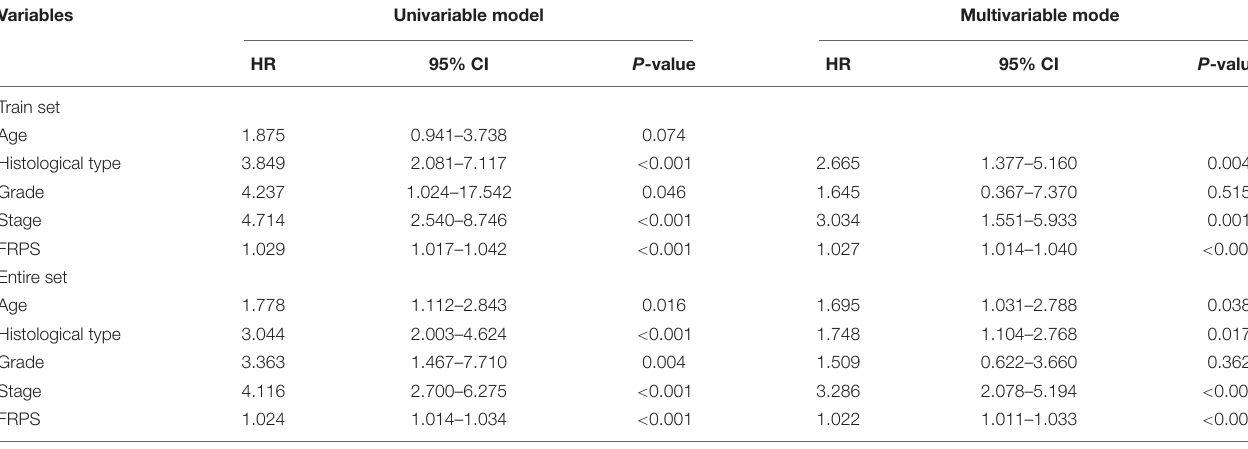
TABLE 2 | Univariate and multivariate Cox regression analysis of the clinical factors and overall survival in different patient sets.